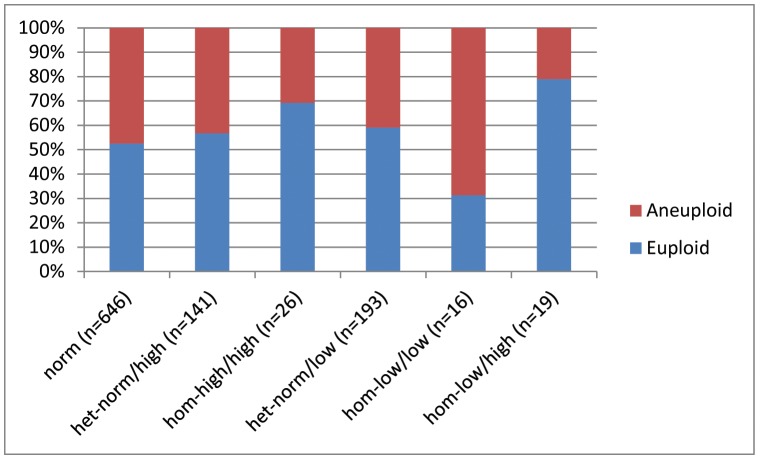
The distribution of embryo ploidy based on patients FMR1 sub-genotype.
FMR1 mutations were not statistically associated with embryo ploidy, though the high aneuploidy rate in biallelic low, hom-low/low women is quite remarkable. Lack of significance may in here-reported findings, therefore, be consequence of small patient numbers. Also of interest is the very low aneuploidy rate in women with one low and one high allele, presenting with only approximately half the aneuploidy rate of even norm women. While these findings, dues to small patient numbers, also need to be viewed with caution, they could suggest a compensatory benefit from a high allele on negative effects of a low allele.